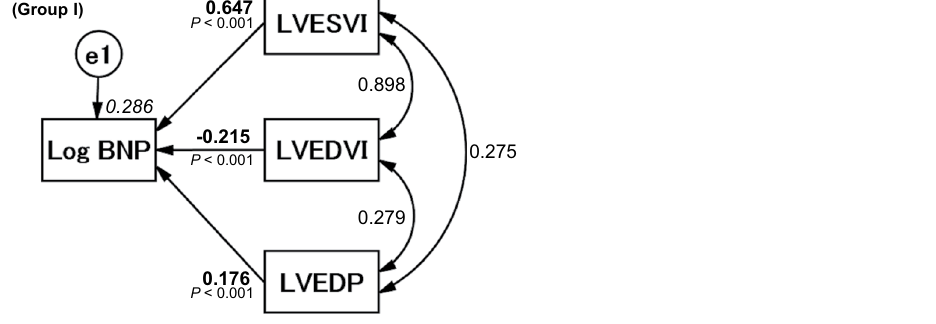
Critical ratios of differences in the significance of the increases in Log BNP between LVESVI and LVEDP. Figure 3 (path model G) and Supplemental Table 8 demonstrate that LVESVI and LVEDP were significantly associated with increases in Log BNP. Finally, we compared the powers of the effects of LVESVI and LVEDP. The critical ratios of the differences between the parameters were examined using a matrix (the full AMOS matrix is not shown because of its size). The results revealed that compared to LVEDP, LVESVI was more strongly associated with Log BNP ( P < 0.001).